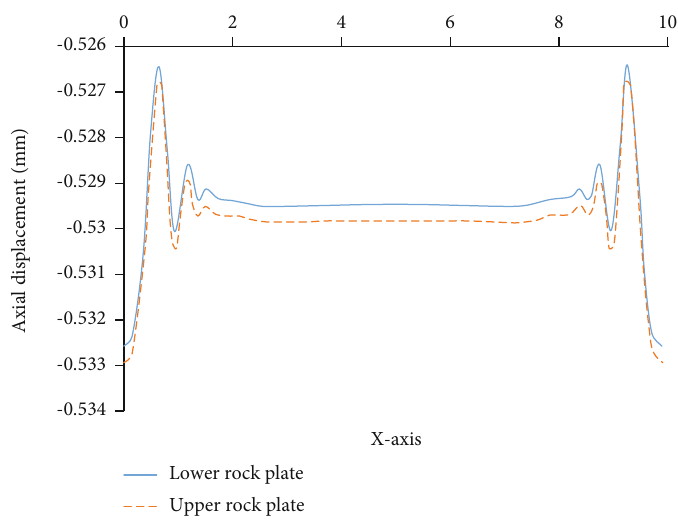
Figure 18: Axial displacement curve of upper and lower slabs.